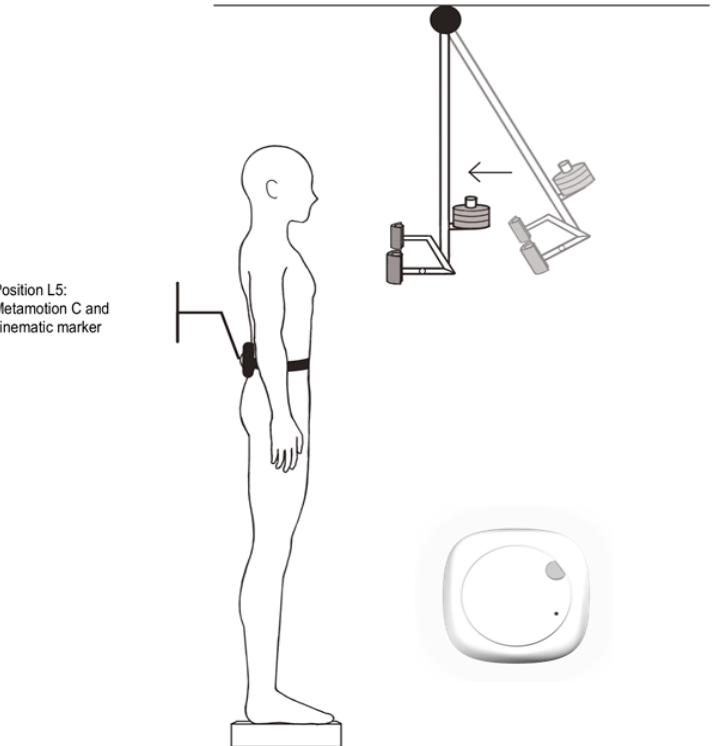
Figure 1. View of the experimental setup showing the participant in front of the pendulum that was released from 0.5 m away, causing a predictable anteroposterior disturbance. In L5, Metamotion C sensor is fixed and the reflective marker on top of it.